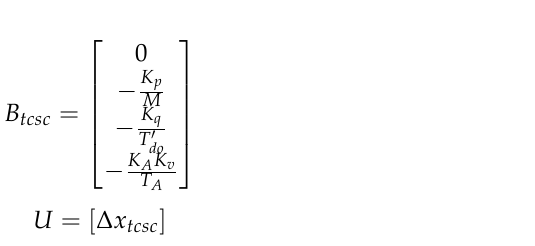
csct x Δ Figure 4. Block diagram of the TCSC PIDF controller .